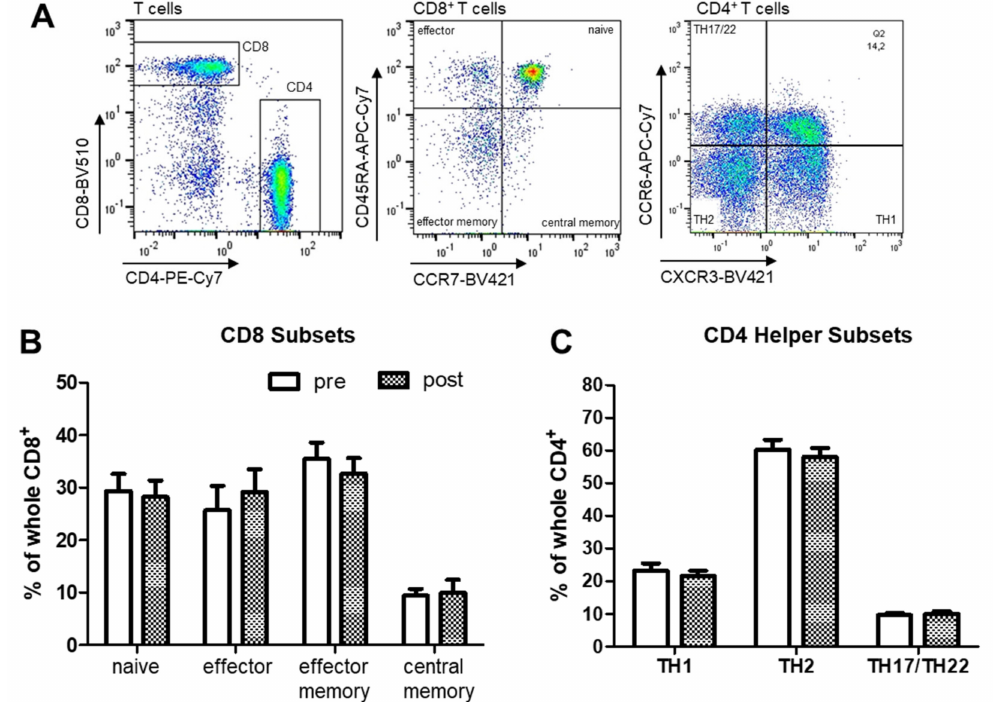
Figure 4. Flow cytometric analysis of CD8 + and CD4 + T helper cell subsets in PBMC from OSA patients ( n = 22) before and after PAP treatment. ( A ): Part of the gating scheme of CD8 + and CD4 + T cell subsets. ( B ): Percentages of naïve, effector, effector memory and central memory T cells within CD8 + T cells. ( C ): Percentages of CD4 + T helper cell subsets TH1, TH2 or TH17/22. There was no statistical significance ( p >